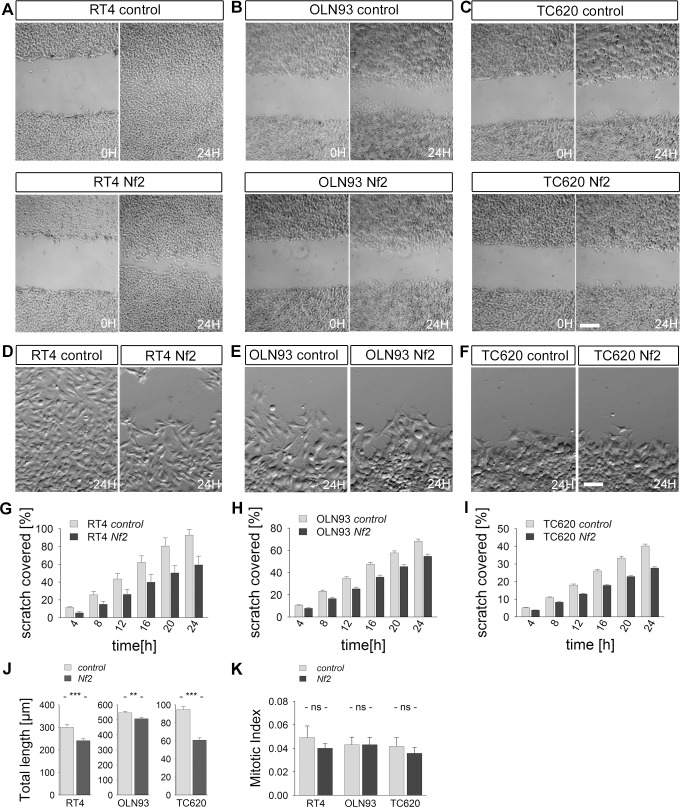
Merlin affects cell proliferation and migration in a scratch assay.Scratched areas are covered by new cells in cultures of RT4 (A, D, G), OLN93 (B, E, H) and TC620 (C, F, I) cell lines, stably transfected with pcNF2hflag (Nf2) and pcDNA3.1 (control). (A-C) Images show scratched areas in the culture at the time of scratching and 24 hrs. later. (D-F) To visualize cell morphology in scratched areas after 24 hrs. in culture, higher magnifications are shown. (G-I) Plots shown represent the percentage of the original cell-free area covered by cells after every 4 hours, during a 24 hour period (mean ± SEM, n = 4, *p < 0.05; **p < 0.01, Two-way ANOVA). (J) Cell tracking revealed a significant reduction in total path length between Nf2- and control- transfected cells (mean ± SEM, nTC620 > 150, nOLN93 > 200, nRT4 > 70, **p < 0.01, ***p < 0.001; Wilcoxon rank test). Please note that RT4 cells have run for only 10 hours due to their higher velocity, while OLN93 and TC620 have run for 30 hours. (K) The mitotic index is given as the number of phosphorylated histone H3 cells as compared to total number of cells. No significant difference could be observed between control- and Nf2-transfected cells. Scale bars: (A) 100 μm, (B) 25 μm.